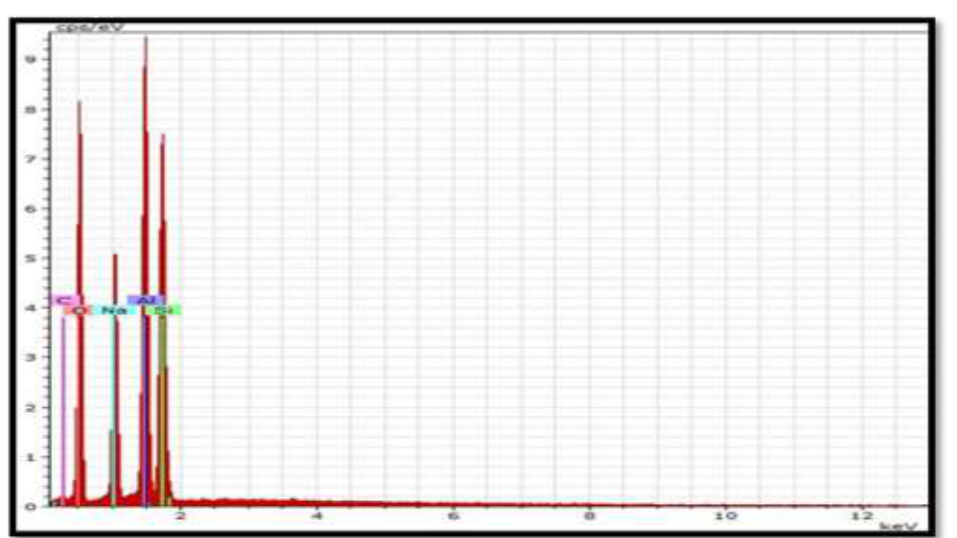
Fig.1: SEM of zeolite.